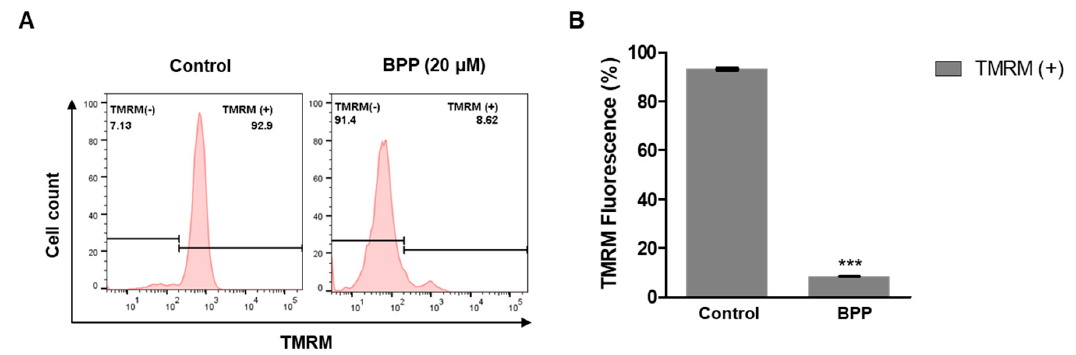
Figure 7. BPP-reduced Jurkat cell mitochondrial membrane potential. ( A ) Mitochondrial membrane potential of Jurkat cells loaded with TMRM (100 nM) and detected by flow cytometry. ( B ) Quantification of mitochondrial membrane potential.